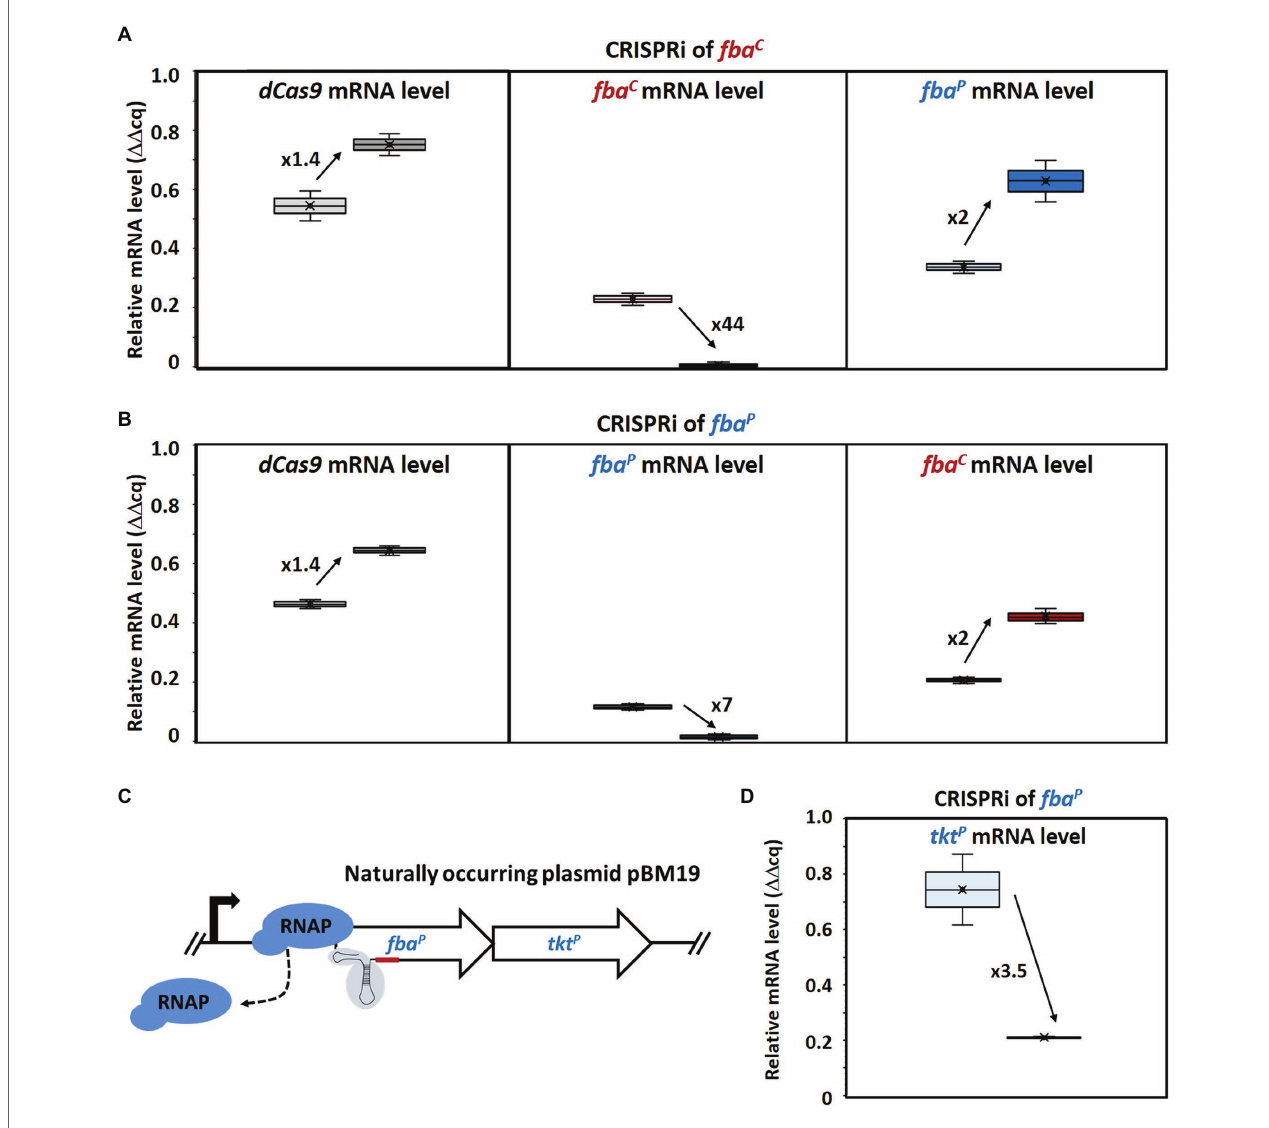
FIGURE 3 | Changed gene expression levels due to dCas9 targeting fba C and fba P and polar effect on tkt P by CRISPRi targeting of fba P . Relative mRNA levels of dCas9 (left), fba C (middle), and fba P (right) in MGA3(piCas- tfba C ) (A) and relative mRNA levels of dCas9 (left), fba P (middle), and fba C (right) in MGA3(piCas- tfba P ) (B) are shown by Box and Whisker plots as detected by qRT-PCR. Schematic representation of CRISPRi targeting fba P , which is cotranscribed with tkt P as bicistronic operon on the natural plasmid pBM19 of B. methanolicus MGA3 (C) . CRISPR interference by blocking transcription elongation by RNA polymerase (RNAP; blue) is shown. qRT-PCR analysis of tkt P mRNA levels upon CRISPRi targeting of fba P in MGA3(piCas- tfba P ) (D) . Black arrows with adjacent numbers indicate up- or downregulation without (lighter color, left) and with (darker color, right) CRISPRi